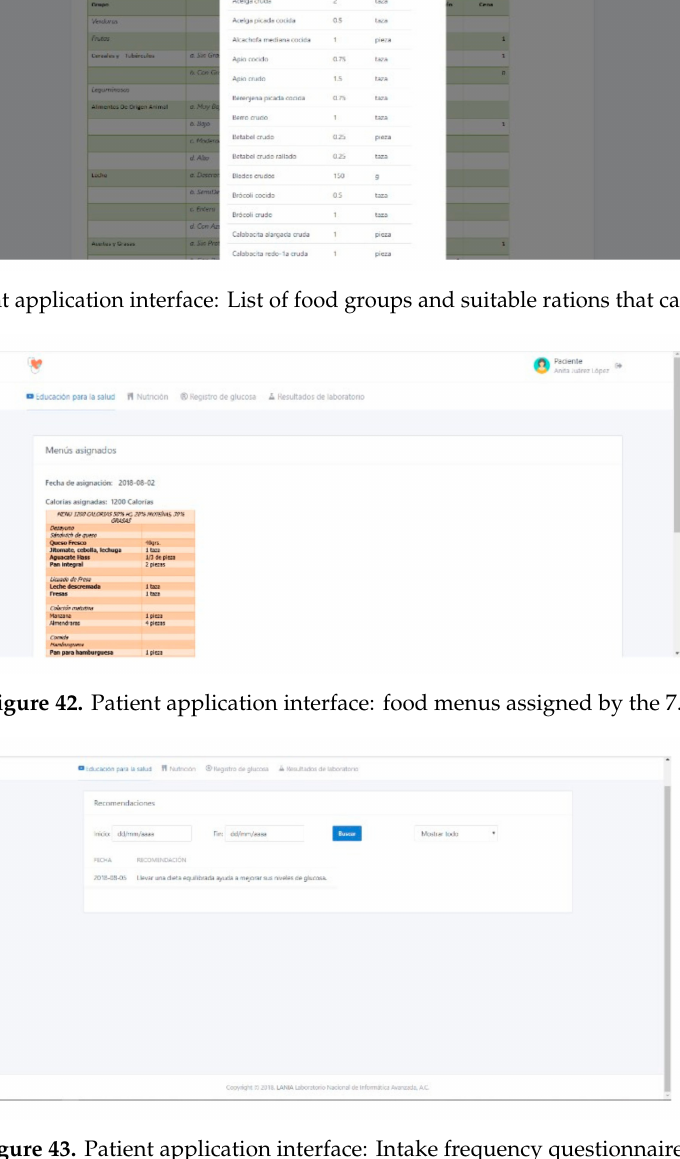
Figure 43. Patient application interface: Intake frequency